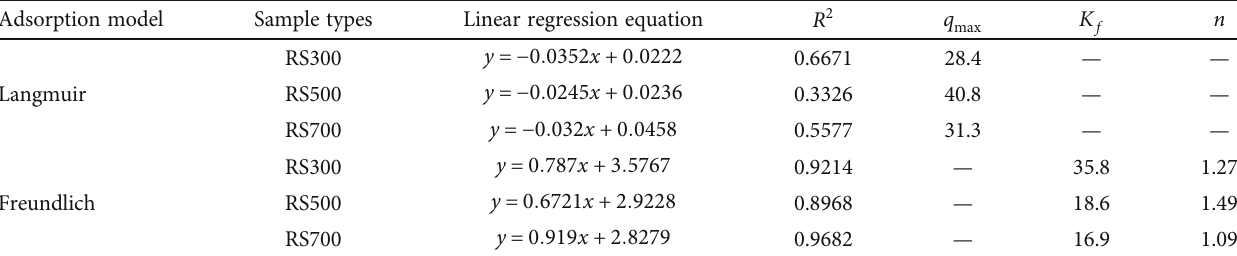
Table 5: Competitive adsorption model of Zn 2+ in acidic solution of straw